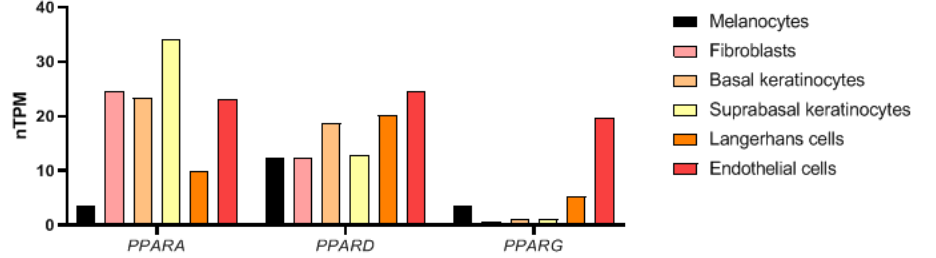
Figure 1. RNA expression of PPARA, PPARD, and PPARG in the single type clusters based on the Human Protein Atlas [15]. The data show gene expression in different cell types within the skin representing the following clusters: melanocytes c-13, fibroblasts c-1, basal keratinocytes c-5, suprabasal keratinocytes c-6, Langerhans cells c-0, endothelial cells c-4. The results are presented as normalized transcript expression values (nTPM — normalized transcripts per million), calculated for each gene in every sample (values < 0.1 are not visualized). All information concerning the bioinformatics analysis of clustering of single cell transcriptomic data and single cell transcriptomic datasets is available at the Human Protein Atlas website (https://www.proteinatlas.org/about/assays+annotation (accessed on 17.01.2023)).